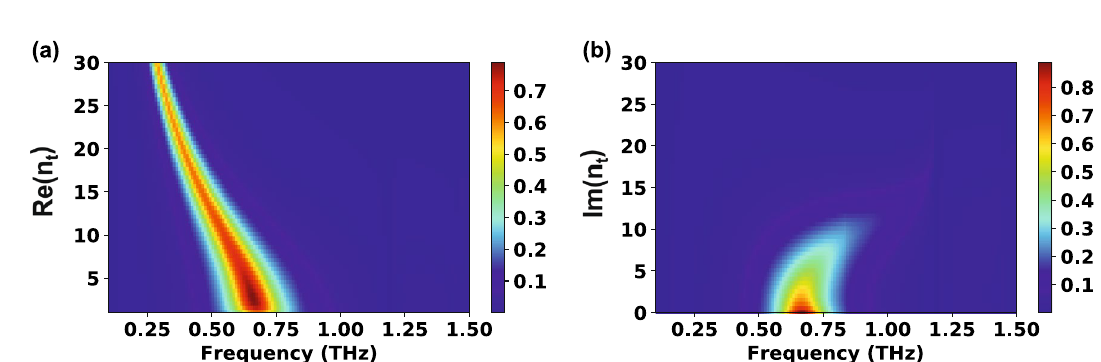
Figure 6. Transmission characteristics of four-layers system with narrower slots. The geometry of the slot antennas: w = 500 nm, l = 150 µ m, h = 70nm, p x = 127 µ m, p y = 180 µ m and d = 240 nm . The refractive index of the substrate is fixed at 2.0. ( a ) Transmission as functions of frequency and Re ( n t ) . ( b ) Transmission as functions of frequency and Im ( n t )